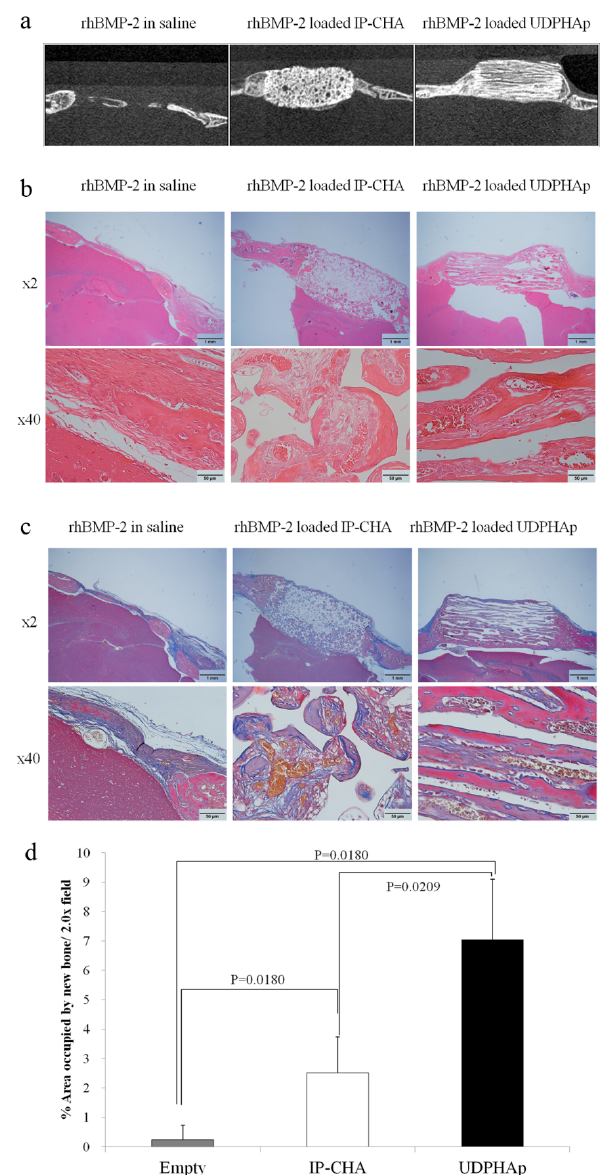
Figure 8. Healing of mouse critical-size calvarial bone defects. Representative images for rhBMP-2 in saline, rhBMP-2 loaded IP-CHA, and rhBMP-2 loaded UDPHAp. ( a ) Representative µCT images (saggital plane) of calvarial defects implanted with saline rhBMP-2, rhBMP-2 loaded IP-CHA and rhBMP-2 loaded UDPHAp three weeks after treatment. Sections were stained with ( b ) Hematoxylin/Eosin (osteoid and nuclei were stained dark pink and dark purple, respectively) and ( c ) Masson’s Trichrome (collagen and woven bone stained blue and mineralized bone stained red). ( d ) Percentage of area occupied by new bone/2.0x field of rhBMP-2 in saline, rhBMP-2 loaded IP-CHA, and rhBMP-2 loaded UDPHAp. Values are mean ± SD; n = 4 analyzed by one-way ANOVA and Tukey’s post hoc test.